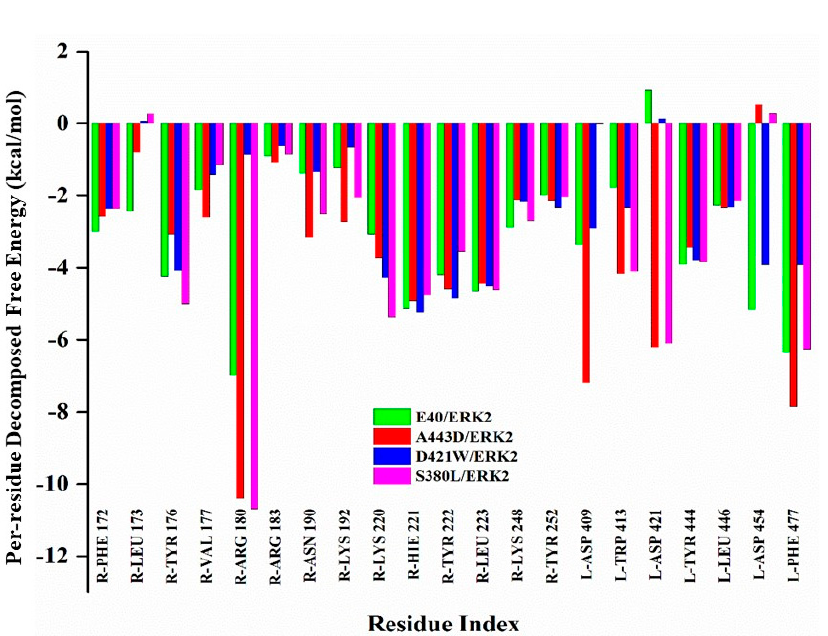
Figure 3. Comparison between the per-residue free energy decomposition of E40/ERK2 and mutants. DARPin residues start with “L”, while ERK2 residues start with “R” followed by a three-letter code of amino acids.